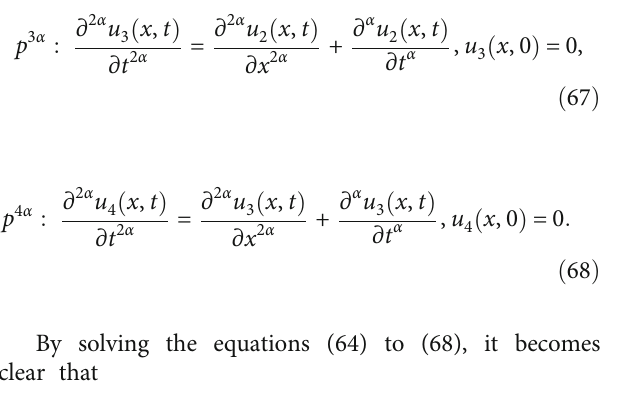
Figure 7: Variation of u ð x , t Þ versus x with α = ln 2/ln 3 , t = 0 : 2, 0 : 6, 0 : 9 sec , relation (71).